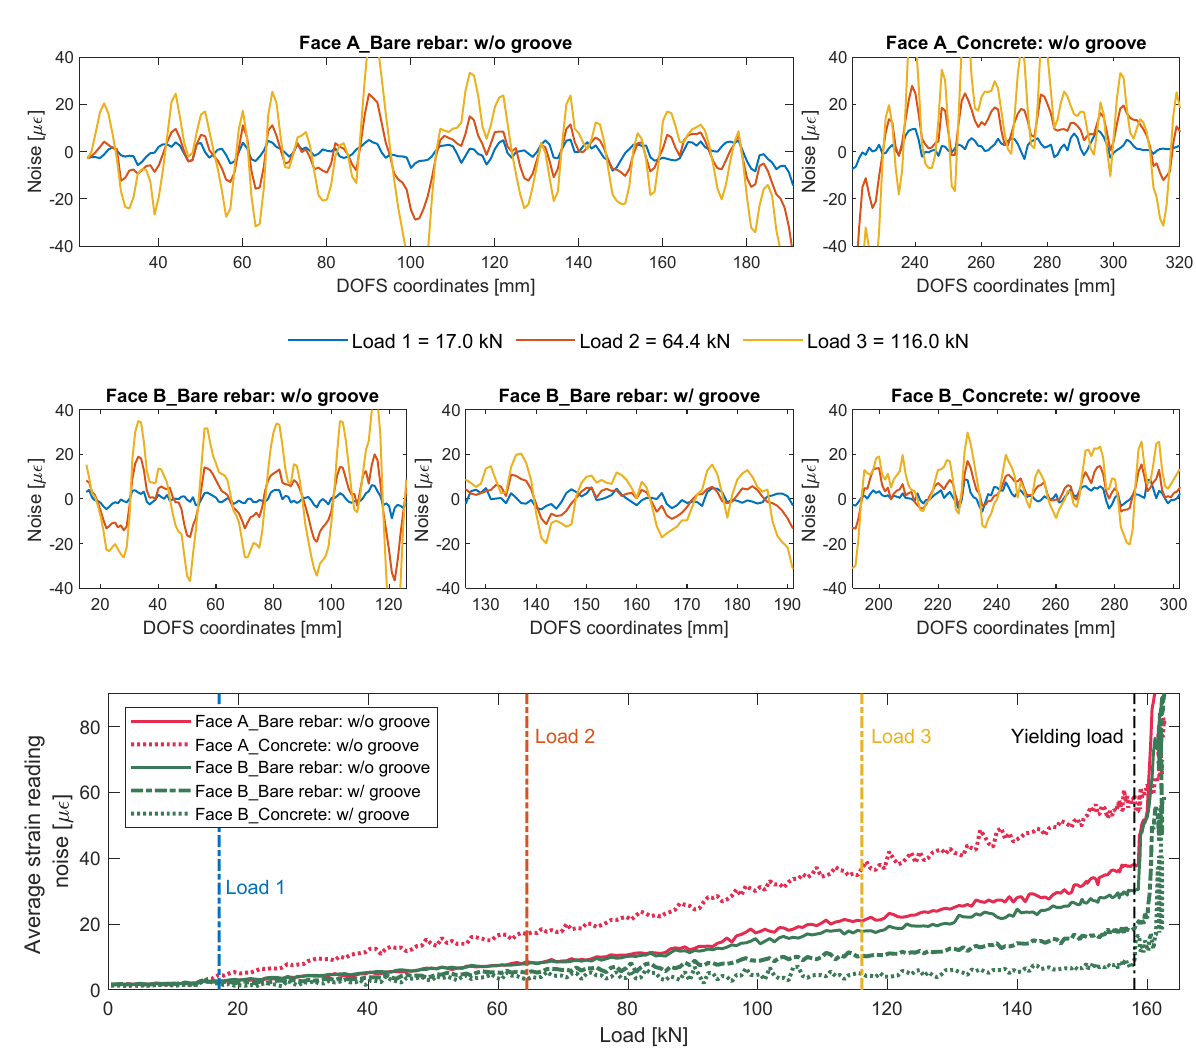
Figure 8. Influence of the rib pattern on the steel strain profiles during the double pull-out test of the RC tie 15 × 15 × 240 mm Ø20 (top five figures). Relative average reading noise (bottom) [49].